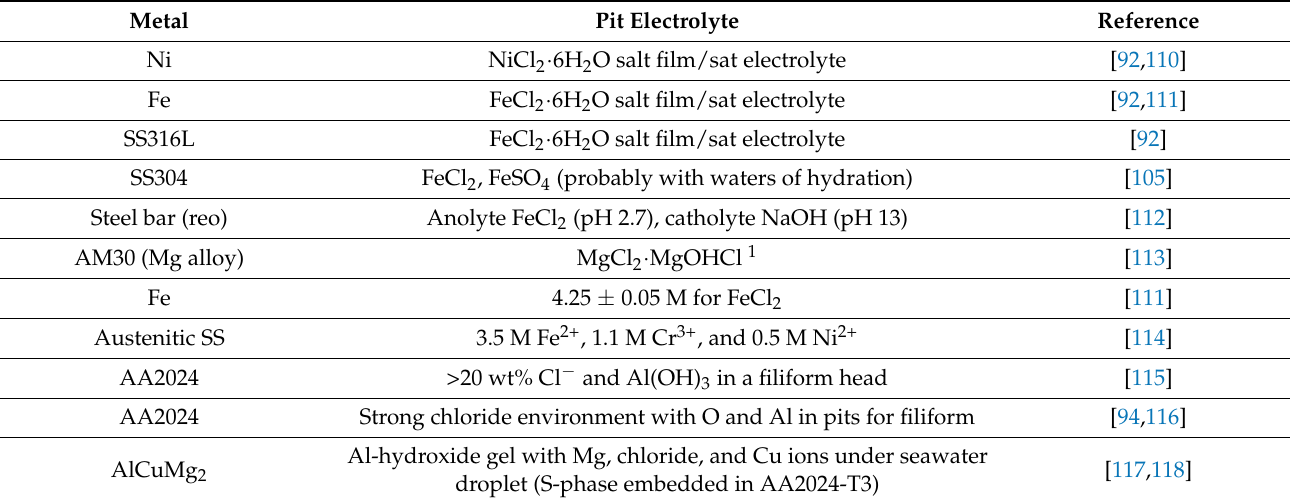
Table 3. Some electrolyte, corrosion product, and salt film